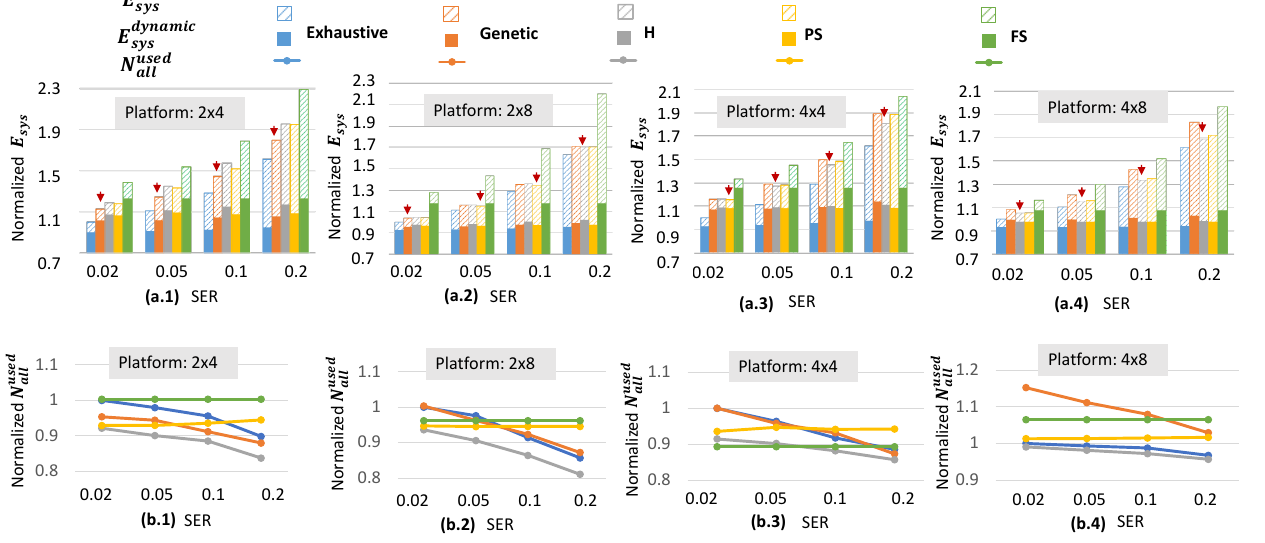
Figure 5. ( a.1 – a.4 ) Normalized E sys (i.e., E dynamic sys + E static sys , in #LCM = 100) and ( b.1 – b.4 ) normalized N used (with regard to exhaustive, SER = 0.02) in all common feasible use cases for different platform all sizes. Results are given to management strategies under constraints of increasing SER (by using the Power static ∝ f 2 model). Note : For a better demonstration, the energy of fully separate strategy is shrunk by a factor of 1.5, 3, 6, 7 in 2 × 4, 2 × 8, 4 × 4 and 4 × 8, respectively. H: holistic strategy, PS: partially separate strategy, FS: fully separate